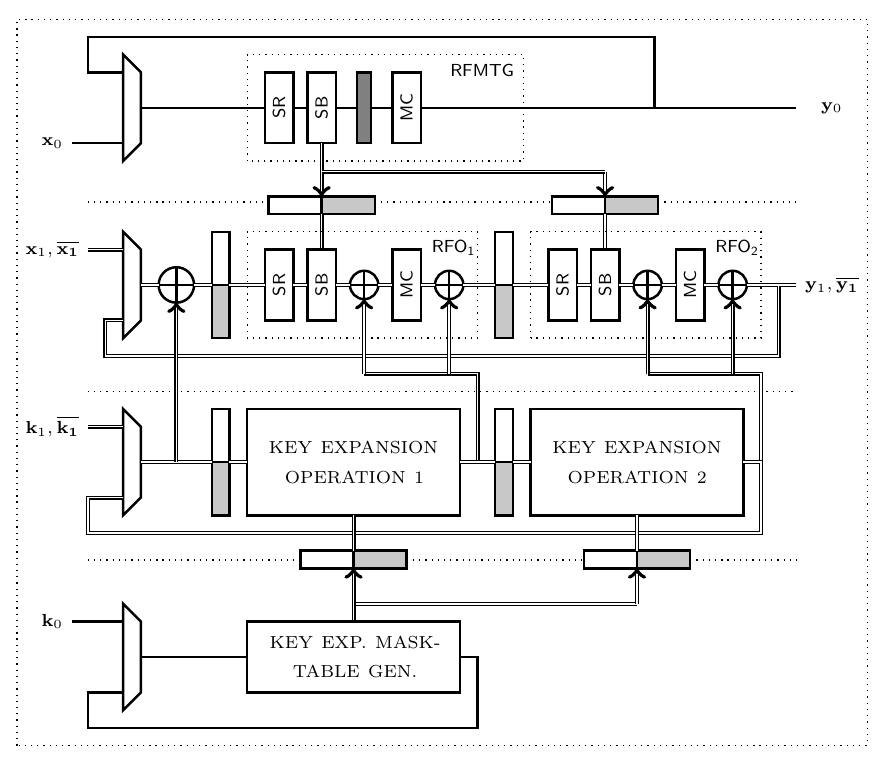
Figure 4: Basic Architecture of the Protected Low-Latency AES. Logic flows left to right and in the direction of the